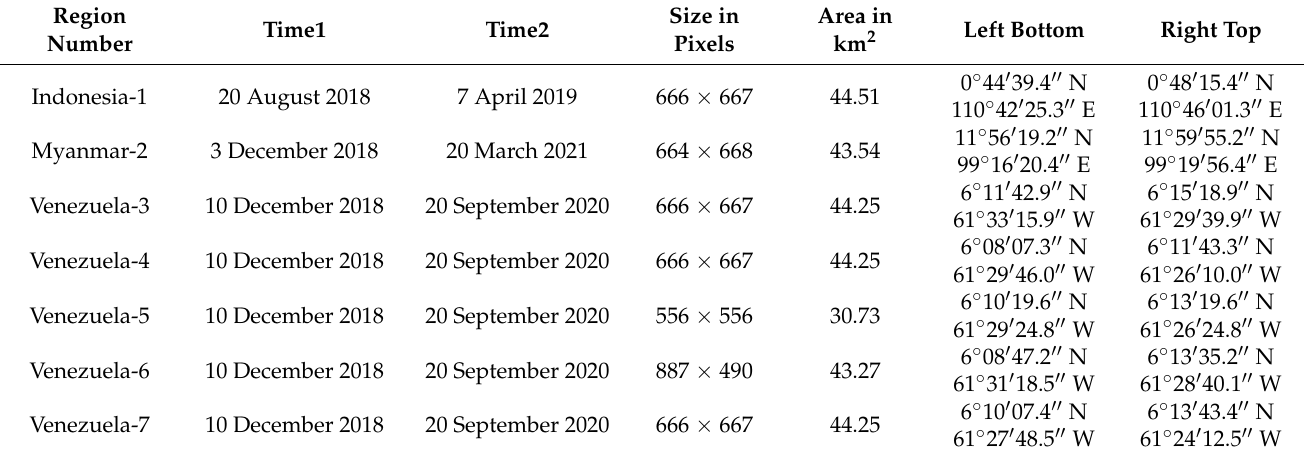
Table A5. The regions in the different parts of the world with their sizes in pixels and km 2 area and latitude and longitude of left bottom and right